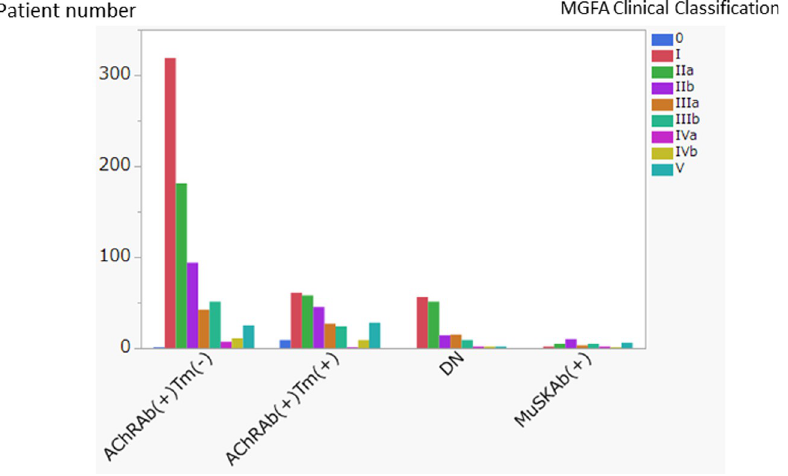
Fig 6. Myasthenia Gravis Foundation of America (MGFA) clinical classification by myasthenia gravis categories. Bar graph plot of Myasthenia Gravis Foundation of America (MGFA) clinical classification of myasthenia gravis (MG) categories. The clinical classification was done according to maximum disease severity. The X-axis indicates categories of MG. Y-axis indicates the patients’ number.